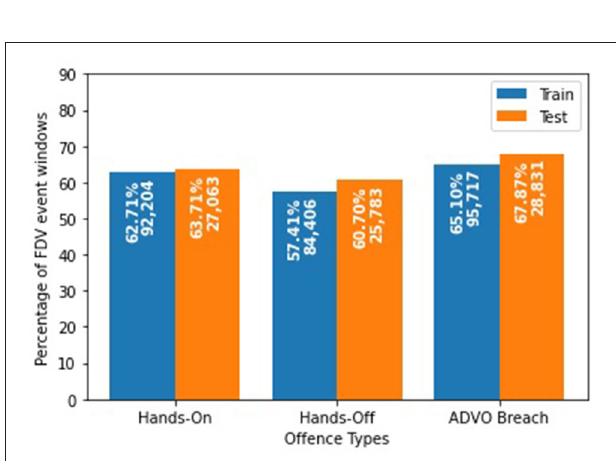
FIGURE 4 | Distribution of the three offense types after data preprocessing in the training and test